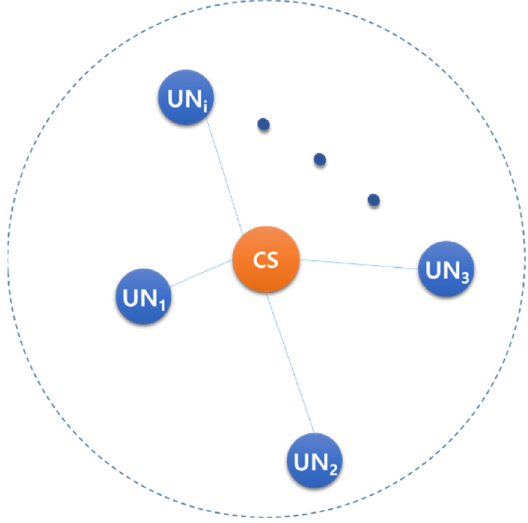
Figure 1. Target network model.